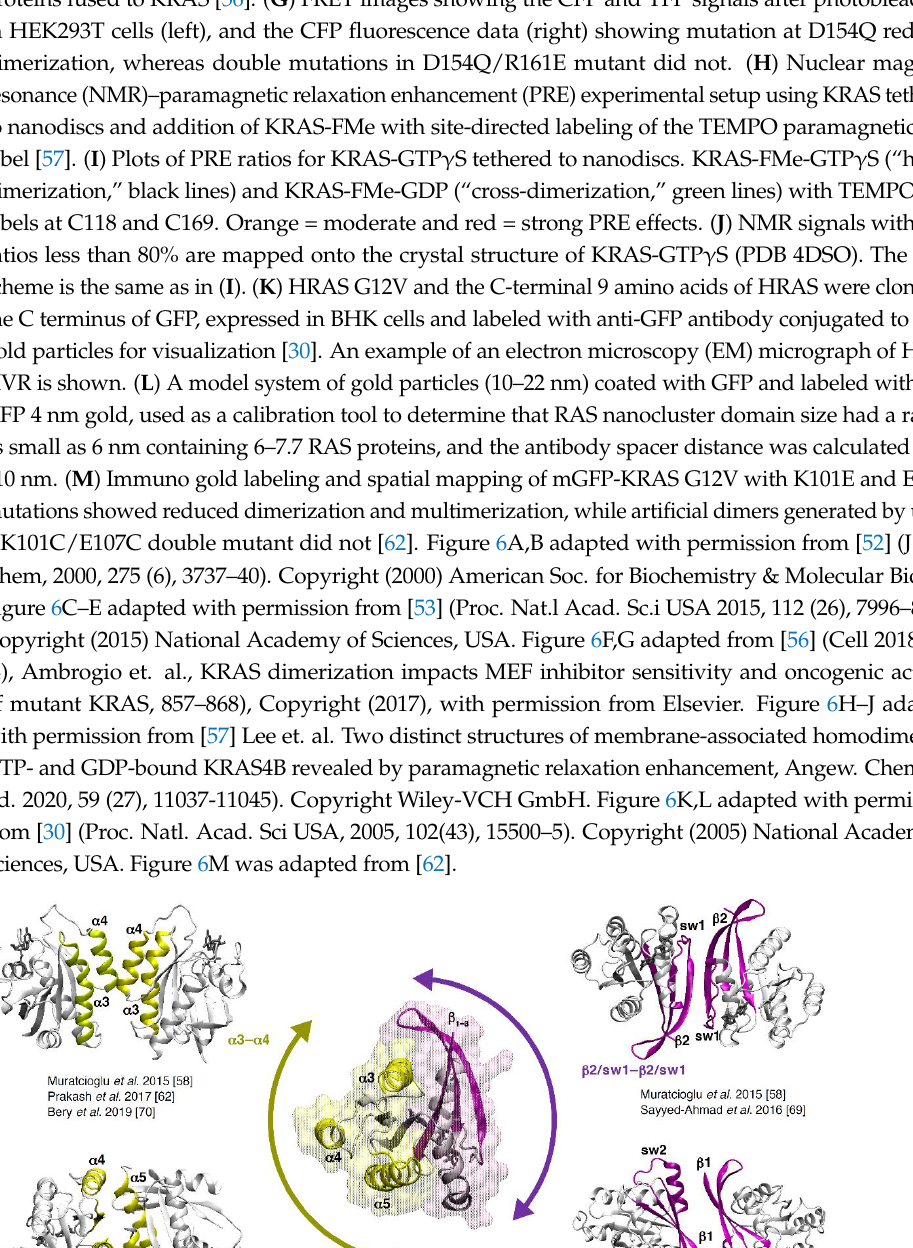
Figure 7. Major RAS dimer interfaces reported in the literature. The central figure shows the secondary structural elements of KRAS involved in dimer formation (PDB 6GJ7). The two lobes of KRAS are highlighted in surface representation, and arrows indicate effector-binding lobe (purple) and allosteric lobe (yellow). The nucleotide is shown in stick representation (gray). The dimer interfaces shown are α 3– α 4 (top left; PDB 4LUC); α 4– α 5 (bottom left; PDB 5US4); β 2/sw1– β 2/sw1 (top right; PDB 6QUX) and β 1/sw2– β 1/sw2 interface (bottom right; PDB: 7ACF). The β 1/sw2 dimer interface is ligand-induced (see Figure 8E for more details). sw1 = switch 1; sw2 = switch